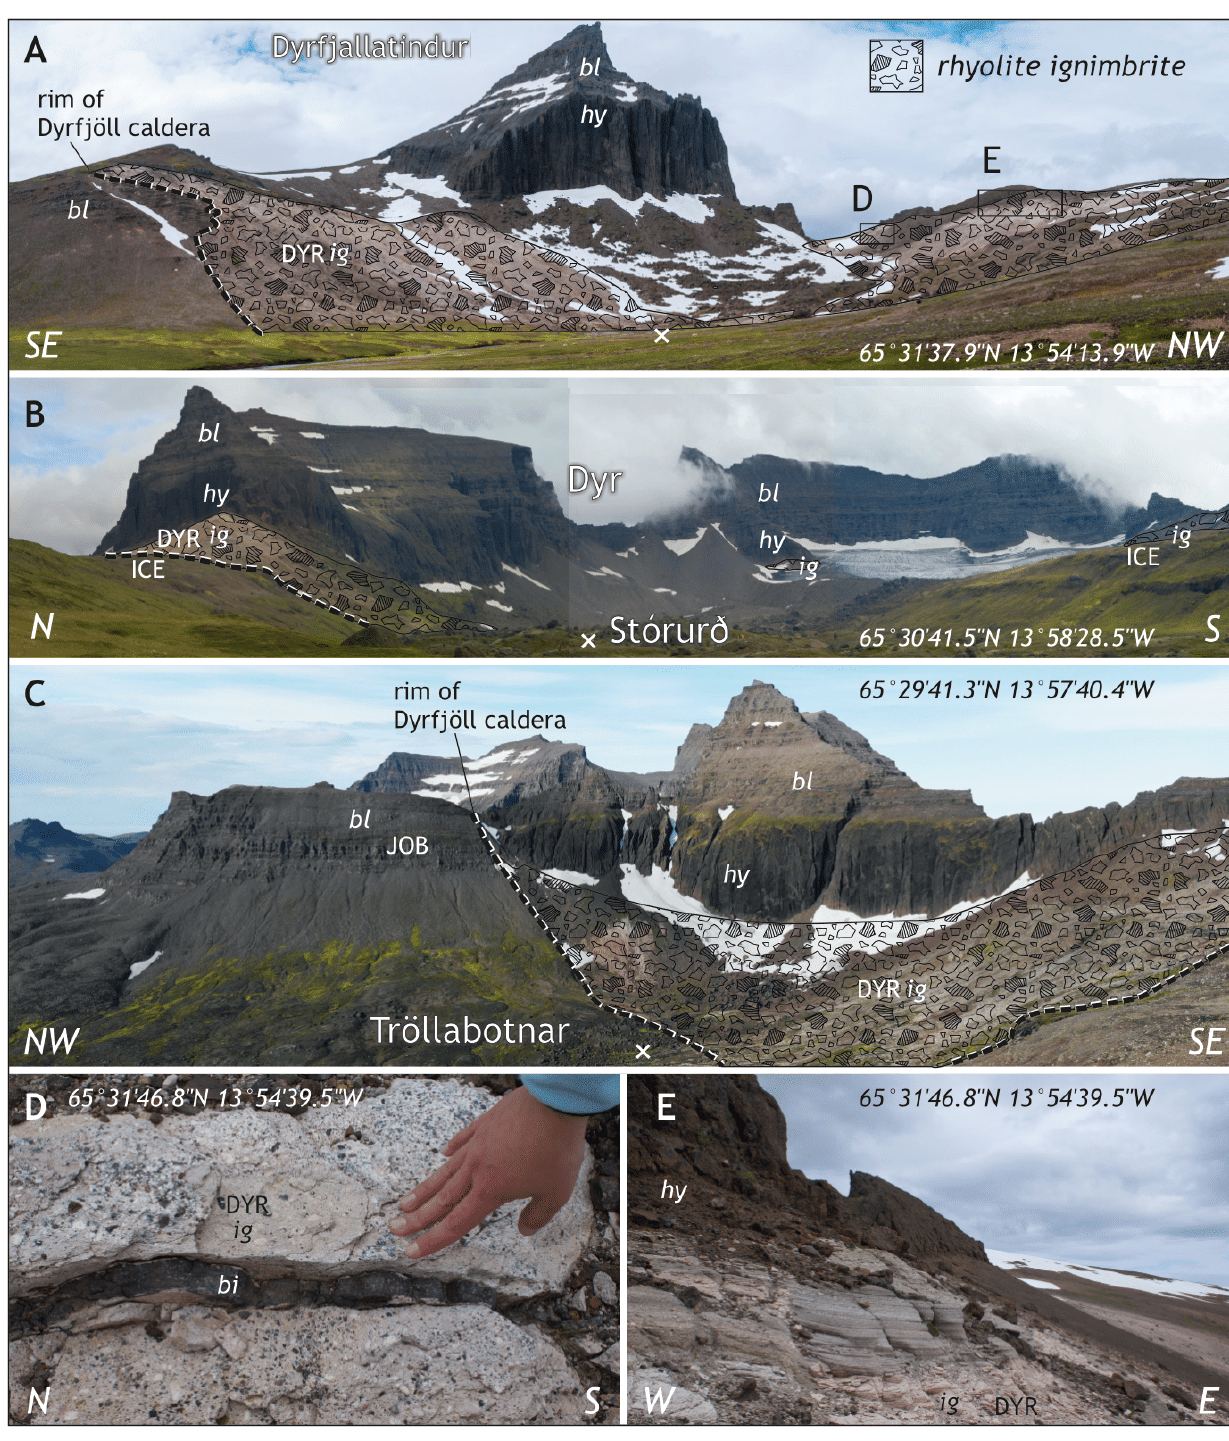
Figure 6: Annotated field photographs illustrating the geology of Dyrfjöll. For locations see Figure 4. Abbreviations: b = basalt, r = rhyolite, hy = hyaloclastite, l = lava, i = intrusion, ig = ignimbrite. × marks the location of the coordinates mentioned in each photograph. For names of stratigraphic formations, see text and Figure 15. [A] to [C] Views of the Dyrfjöll caldera rocks, including the caldera margin (dashed line), the caldera-filling rhyolitic ignimbrite, the hyaloclastite (massive brown rock unit) erupted in the caldera lake, and the flat-lying olivine basalt lava flows that covered the entire volcanic complex, forming the mountain peaks. [D] thin basaltic dyke cutting through the Dyrfjöll ignimbrite that contains white pumice and dark basaltic lithics. See hand for scale. [E] Layered airfall deposits at the top of the Dyrfjöll ignimbrite. Thickness here approximately 2 m. The brown rocks overlying the airfall deposits are the base of the basaltic hyaloclastite erupted in the caldera lake. Locations of [D] and [E] marked in